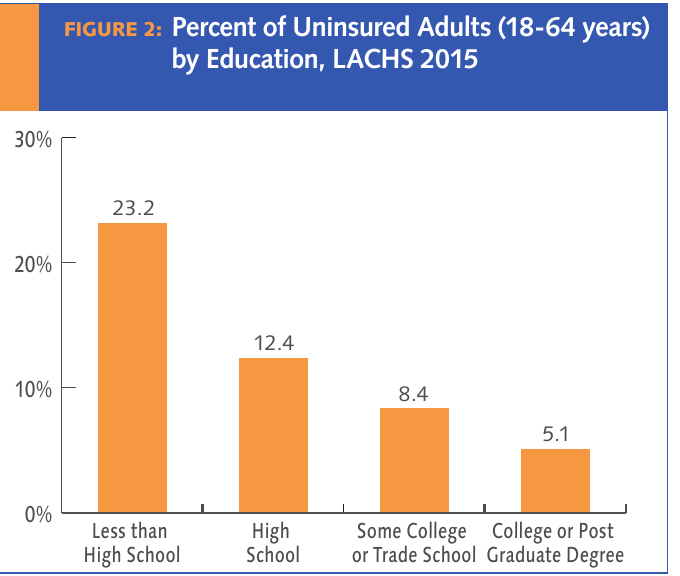
FIGURE 2: Percent of Uninsured Adults (18-64 years) by Education, LACHS 2015